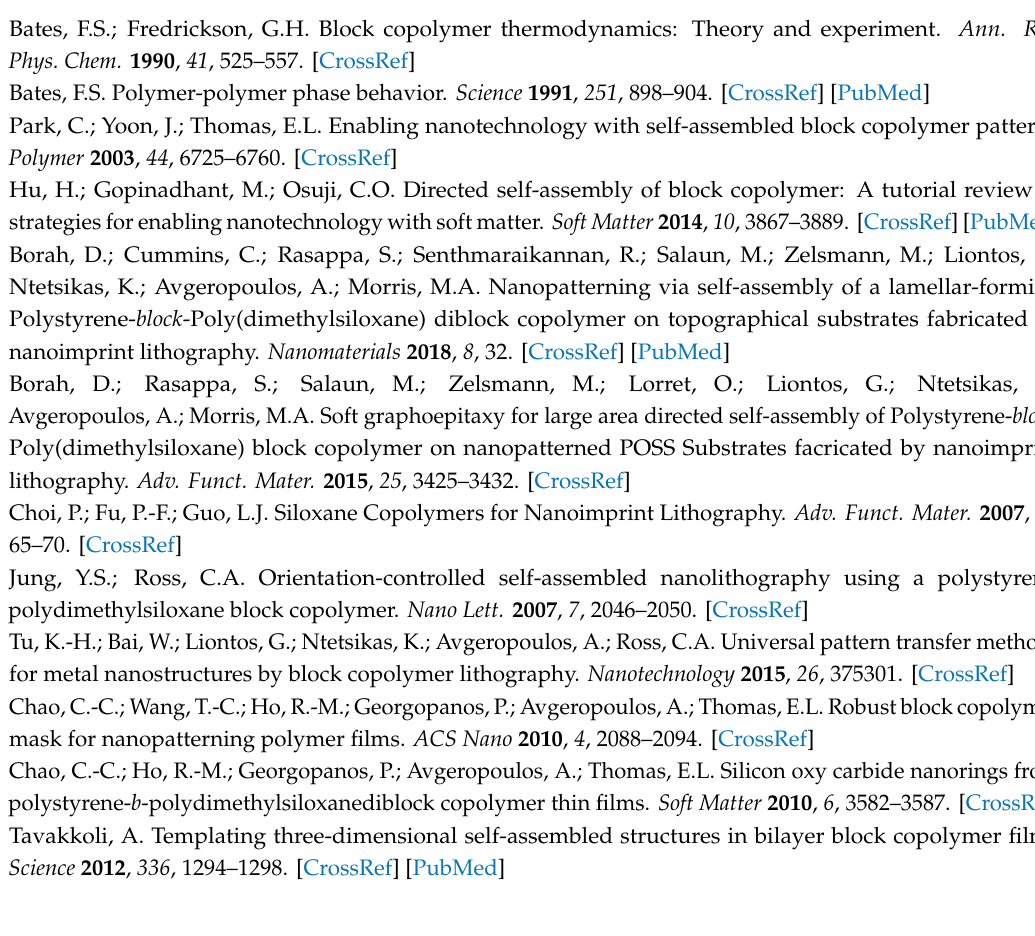
for the three di ff erent blocks in the synthesized final triblock terpolymers. Figure S7: DSC thermograph of